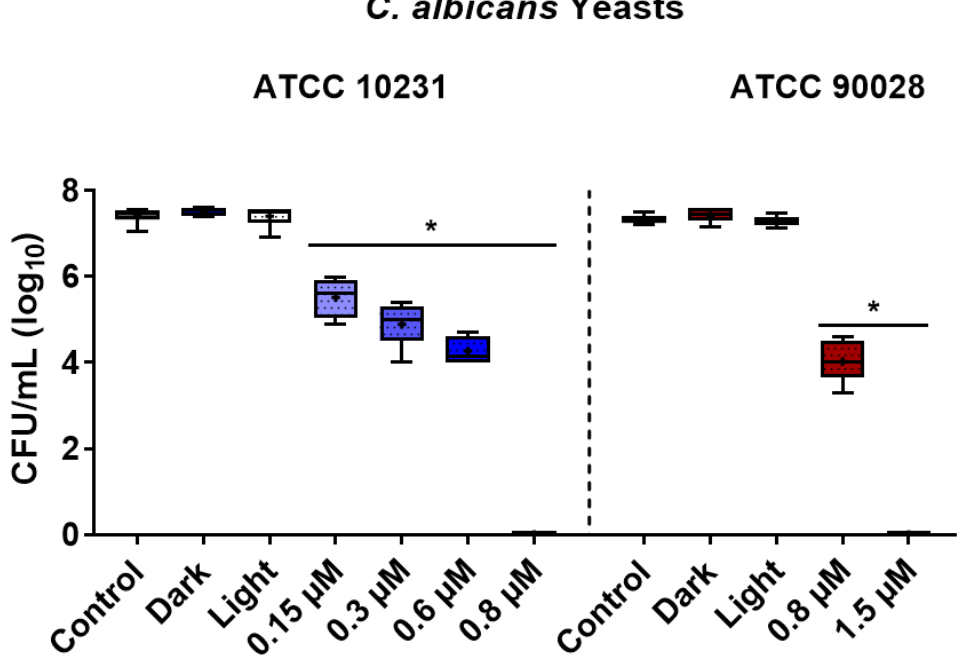
Figure 1. Box plots of photoinactivation of C. albicans yeasts. Two different strains were assessed, ATCC 10231 and ATCC 90028. Control: untreated group; dark: yeasts incubated with 1.5 µM of ZnP hexyl without irradiation; light: yeasts irradiated only (4.3 J/cm 2 ). The values on the ‘x’ axis indicate the concentrations of ZnP hexyl for different aPDI groups. Differences between groups were analyzed by the Mann–Whitney test and considered significant at p < 0.05. The results are expressed as log 10 of the CFU/mL. At least three independent experiments were performed. *: p < 0.05 compared to control.